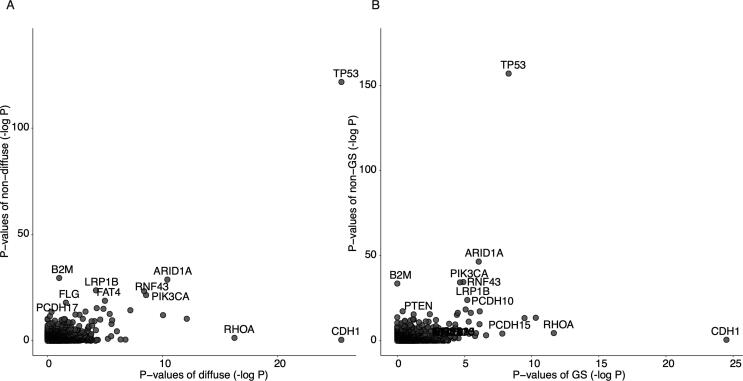
Distribution of P-values of significantly mutated gene detection. (A) P-values in the diffuse against non-diffuse type and (B) P-values in the GS against non-GS subtype. All the P-values were transformed to negative log10 P-value.